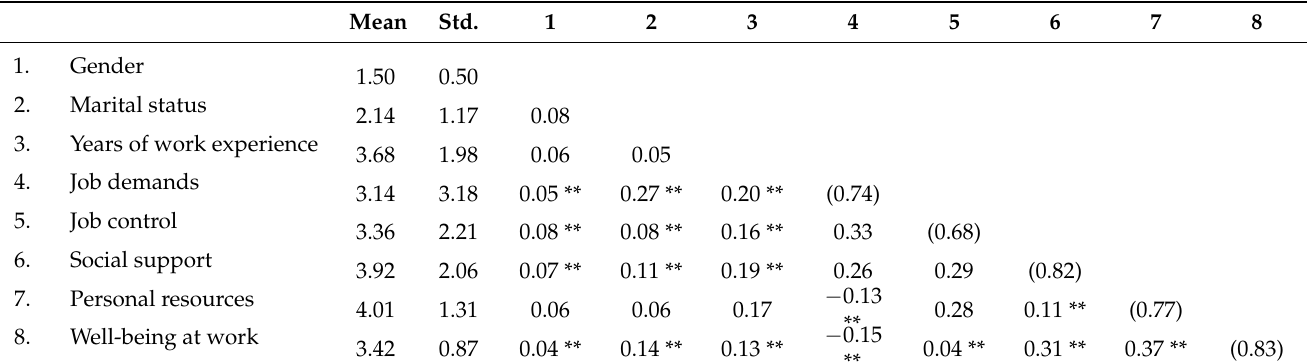
Table 1. Descriptive statistics and correlations among the